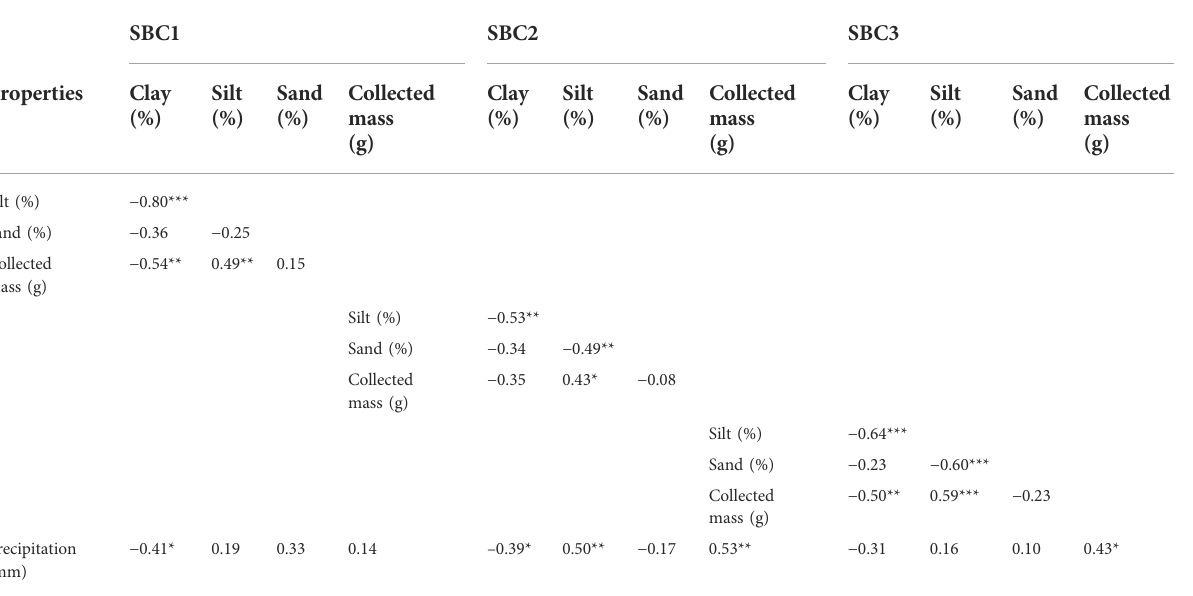
TABLE 5 Pearson correlation coef fi cients between particle size, collected mass, and precipitation for the three sub-catchments (SBC1, SBC2, and SBC3).